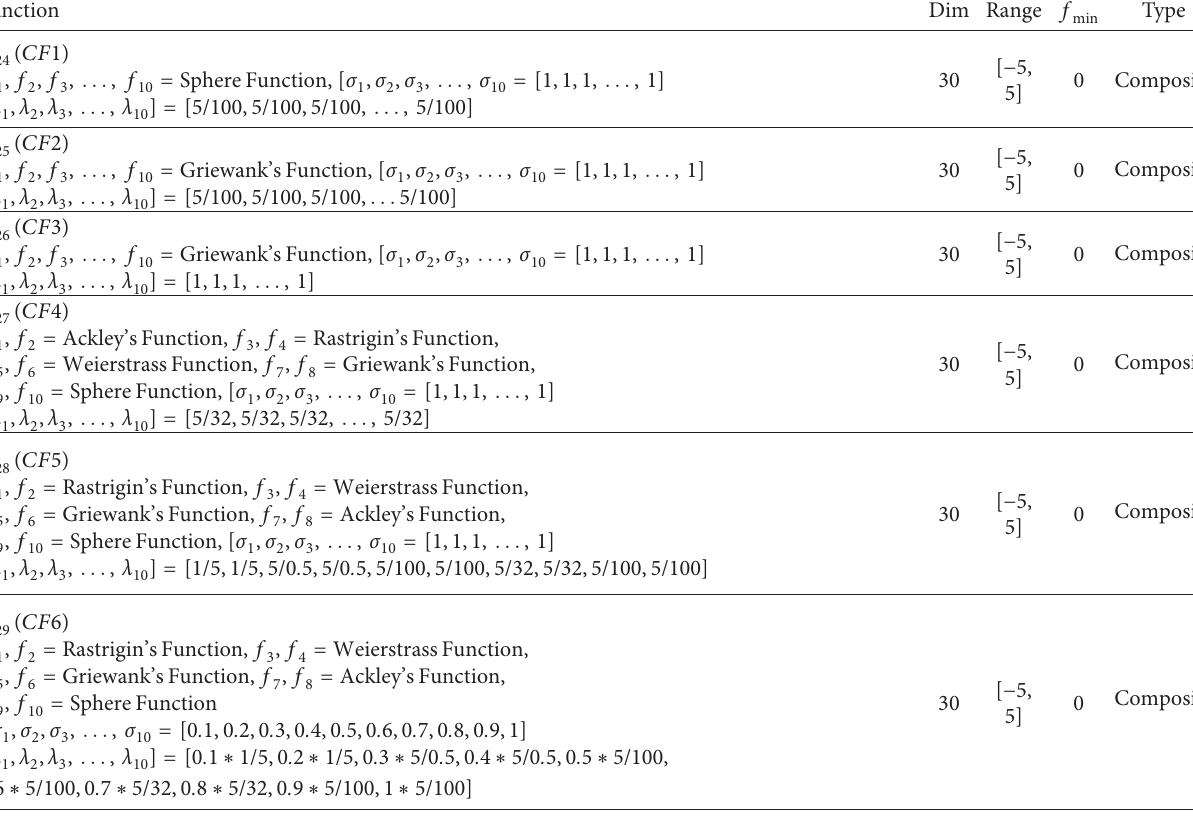
Table 2: Composite functions.